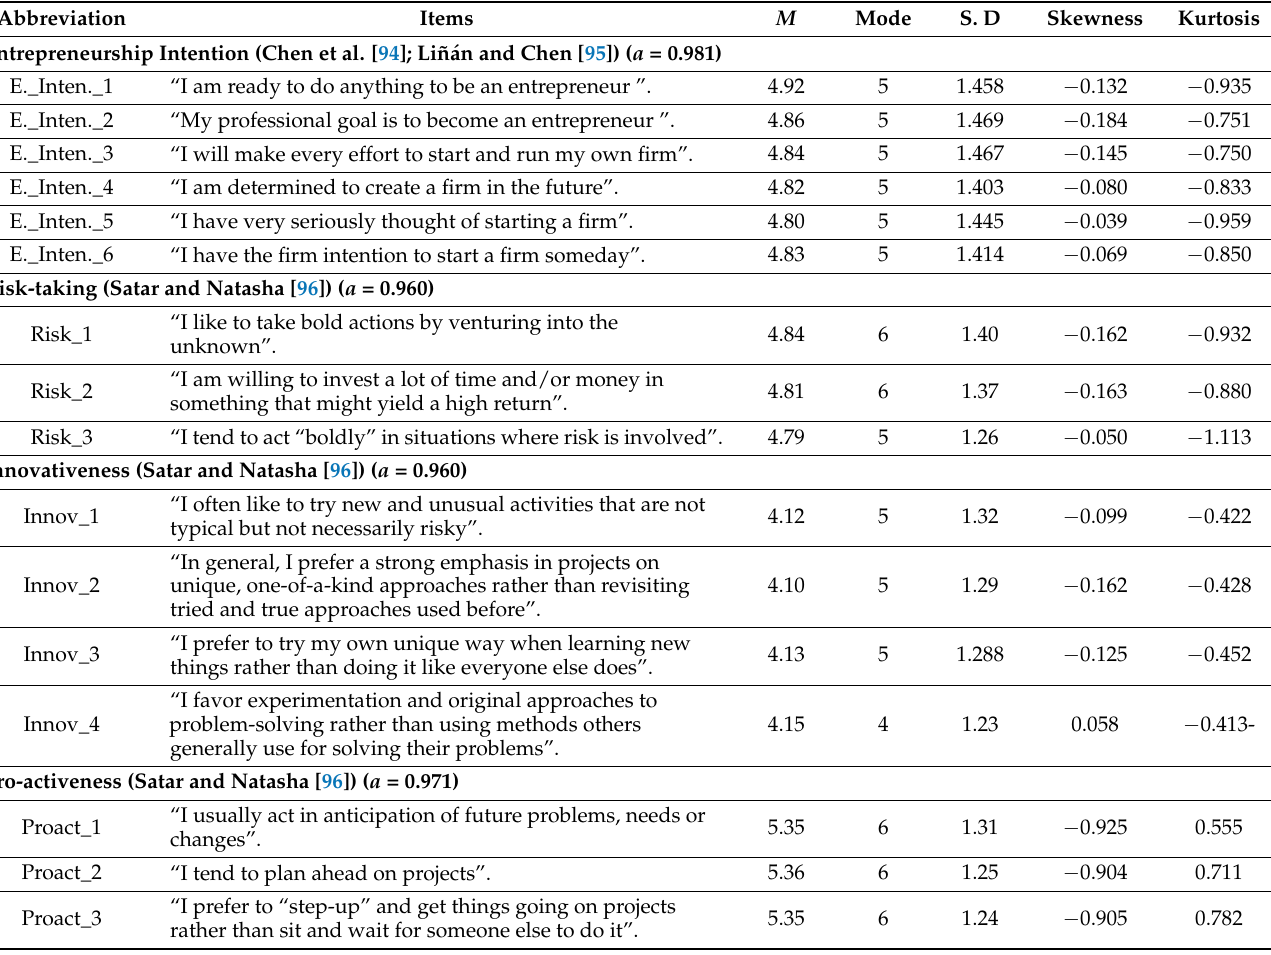
Table 1. Descriptive statistics (mean, mode, standard deviation, skewness, and kurtosis).